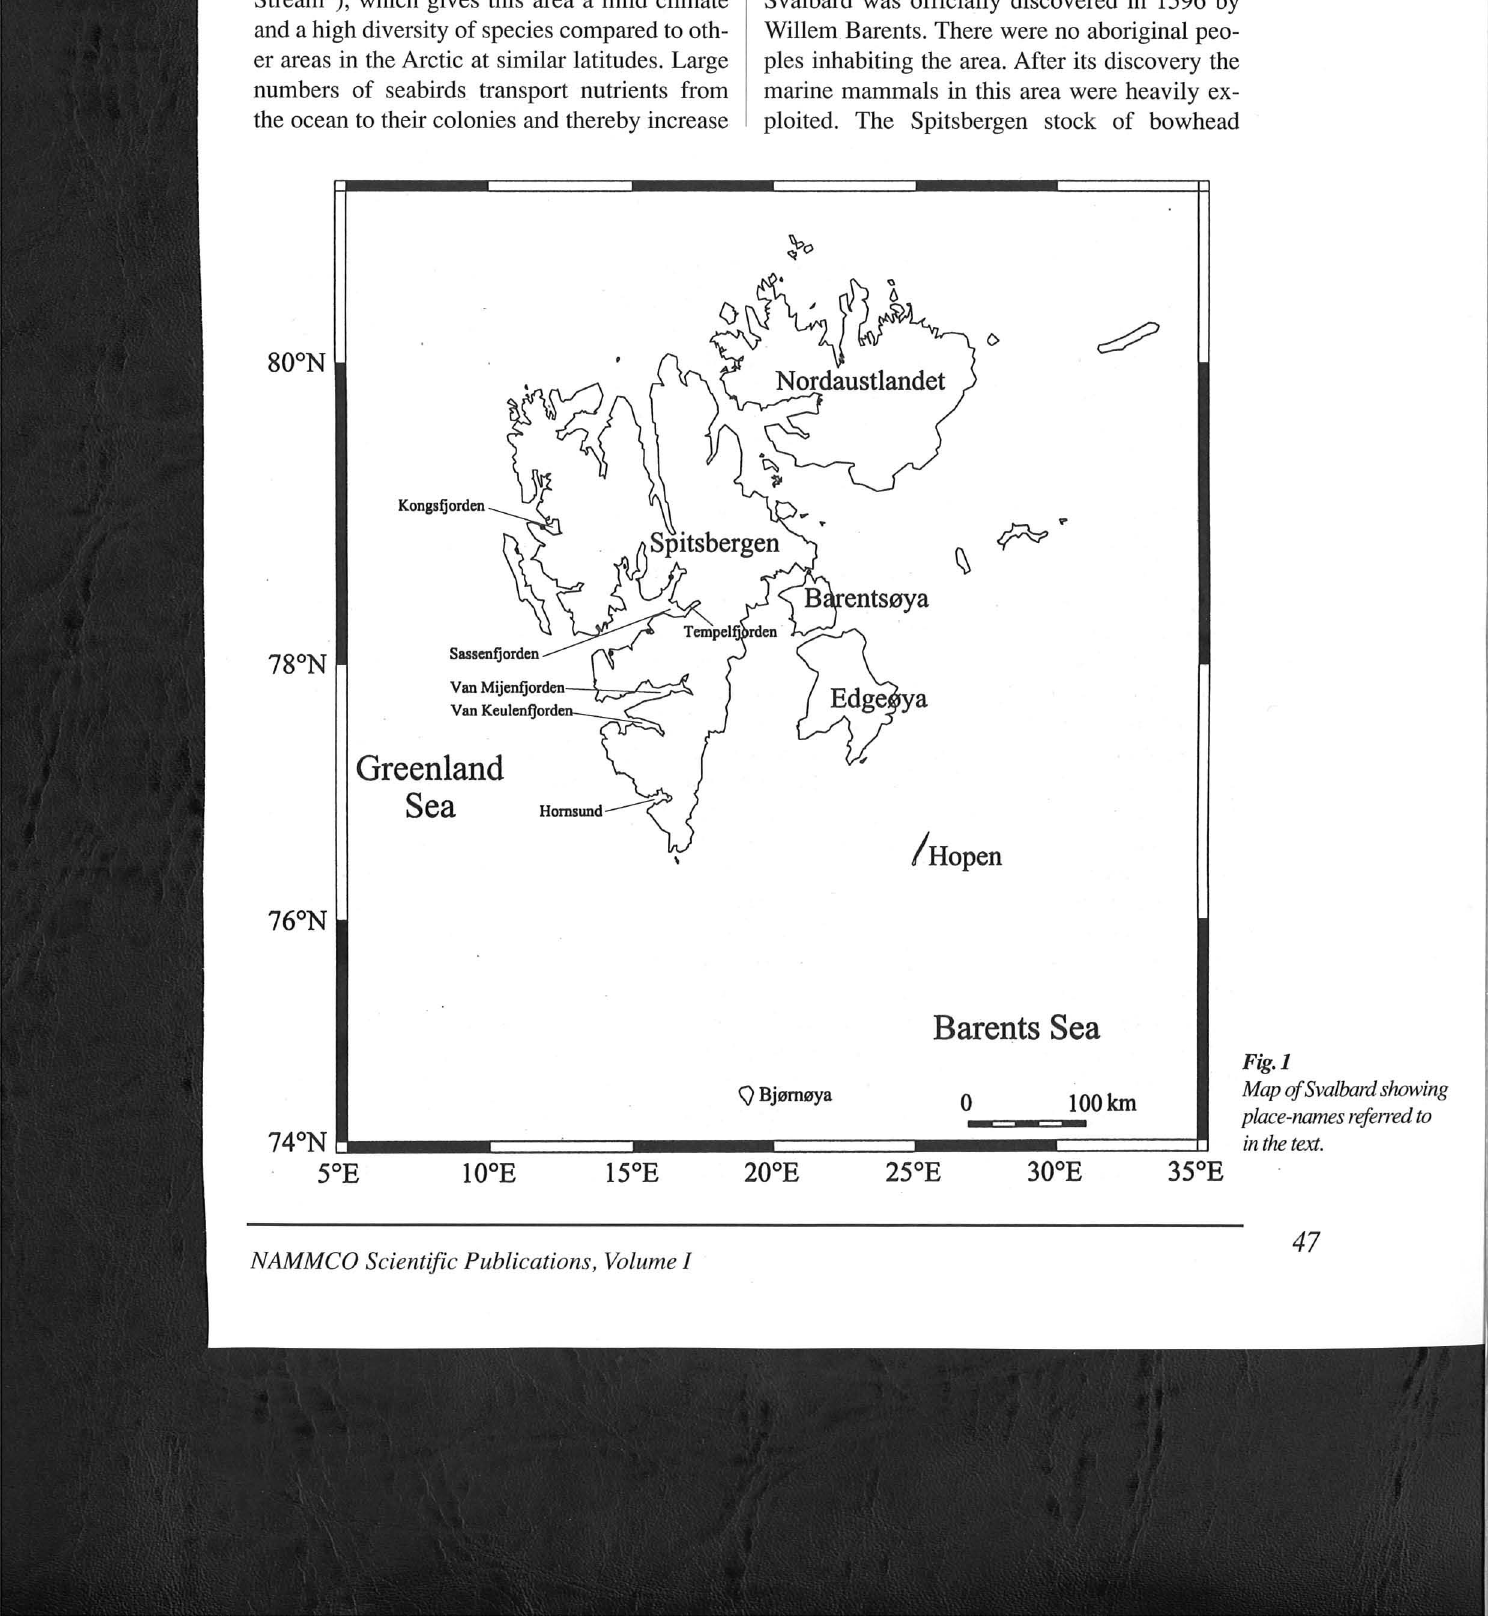
Fig.} Map of Svalbard showing place-names rejel71!d to in the